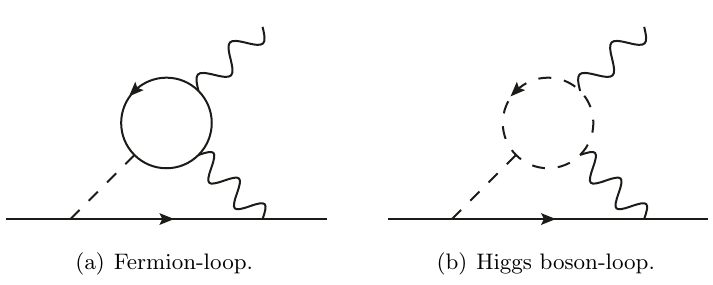
Figure 1 . BZ type diagrams contributing to the electron